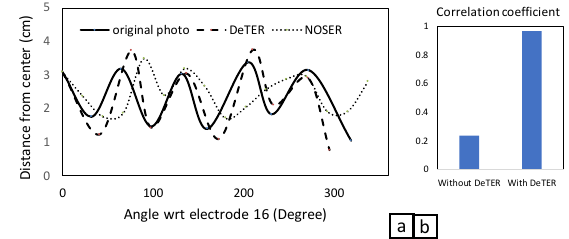
Fig.14: (a) Shape descriptor functions for void in papaya1 and its images. (b) Comparison of correlation